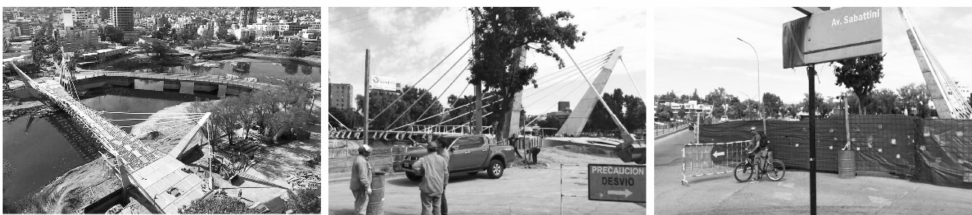
Figure 16. (left to right) Road disruption during construction: the main source of negative reporting, affecting pedestrian and bicycle traffic as well as key trunk services for almost two years. (Credit: Left: From public television broadcast (Cordoba Governance); Centre and Right: reproduced with permission from the author Mr. Mario Rojas (Centedario digital publication)).